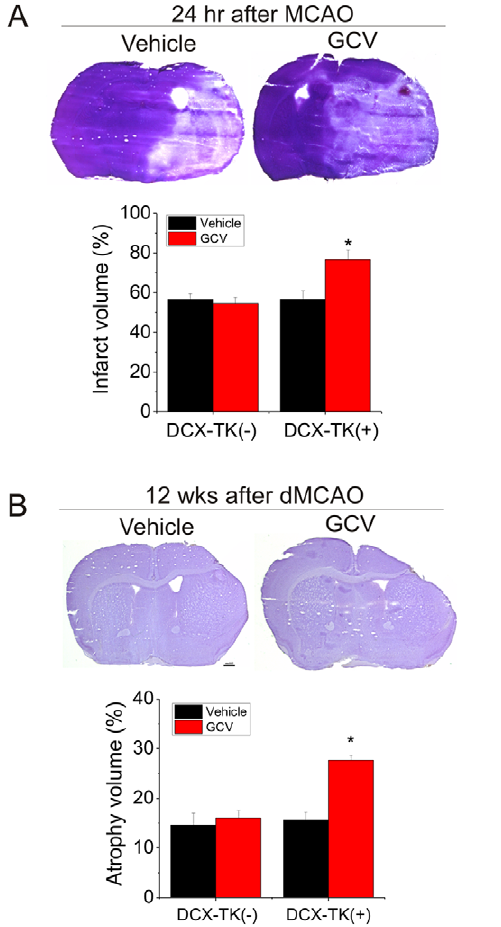
Figure 2. Infarct volume or volume loss in middle-aged DCX- TK ( 2 ) and DCX-TK ( + ) transgenic mice after dMCAO. ( A ) Middle- aged DCX-TK ( 2 ) and DCX-TK ( + ) transgenic mice were treated with vehicle or GCV for 14 days, underwent MCAO, and were killed 24 hr later. Top panel: representative images of infarct area in H&E-stained coronal brain sections. Bottom panel: infarct volumes, expressed as percentage hemispheric volume. * P , 0.05. ( B ) Middle-aged DCX-TK ( 2 ) and DCX-TK ( + ) transgenic mice were treated with vehicle or GCV for 14 days, underwent dMCAO, and were killed 12 weeks later. Top panel: representative images of atrophy area in H&E-stained coronal brain sections. Bottom panel: volume loss, expressed as percentage hemi- spheric volume. * P , 0.05.